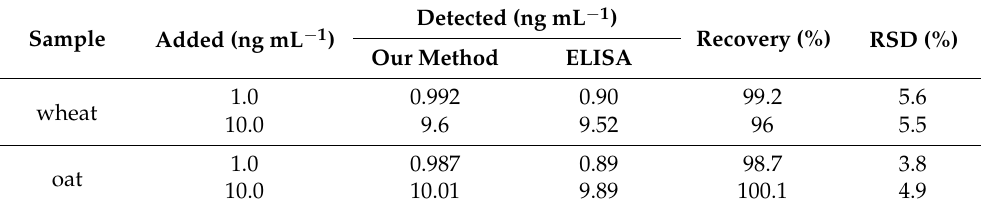
Table 3. The OTA detection in wheat and oat samples ( n =